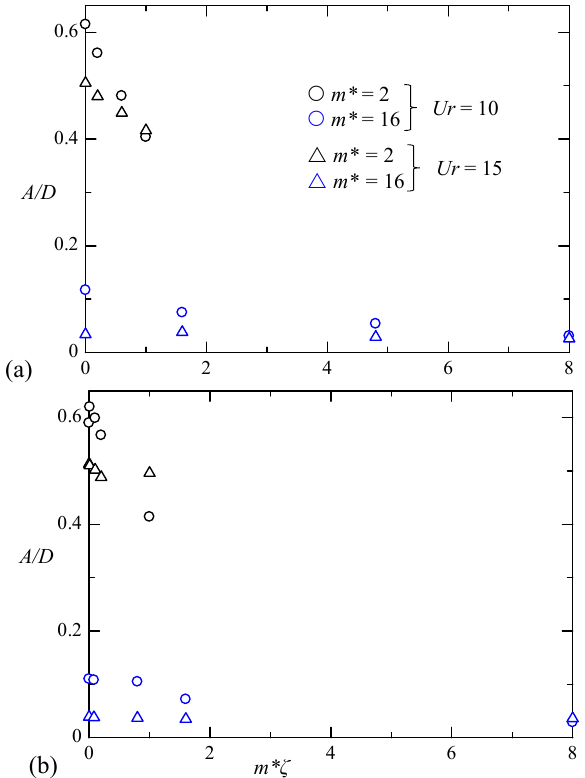
Figure 10. A/D vs. mass-damping ratio (m* ζ ). ( a ) L/D = 3.0, and ( b ) L/D = 1.5.